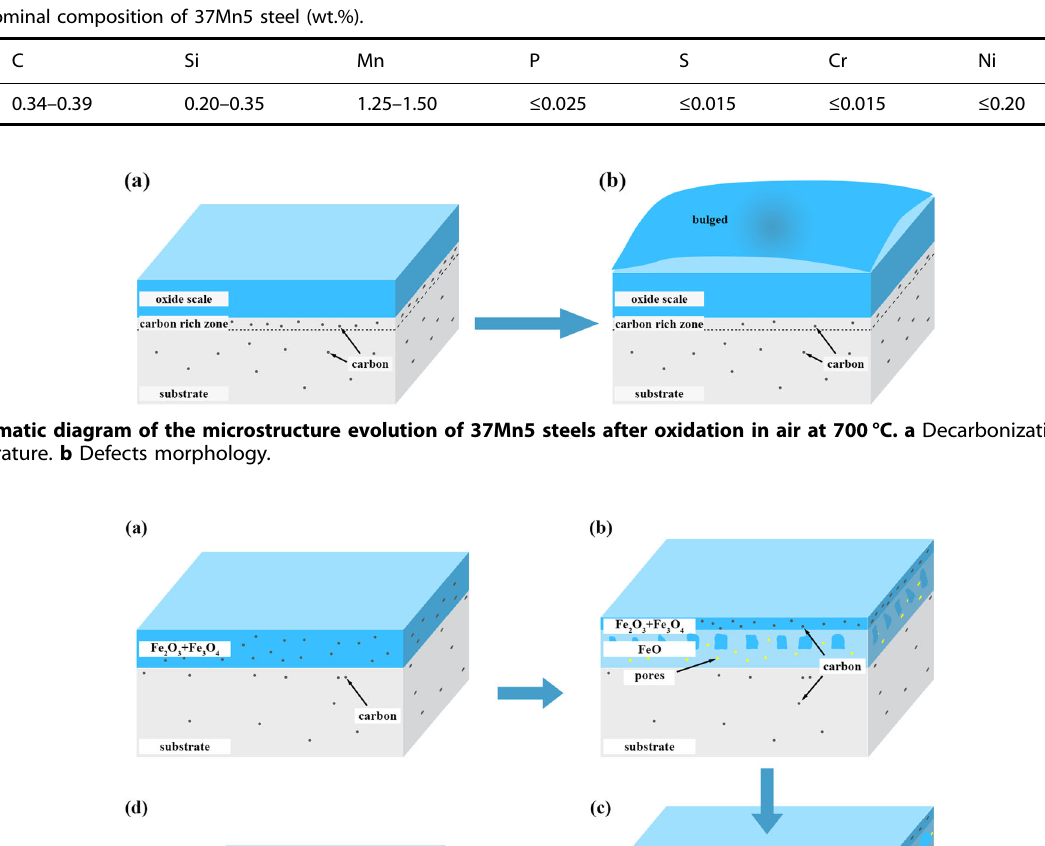
fast initial oxidation stage after 4 min. The weight gain of 37Mn5 steel in kerosene atmosphere is about four times, two times larger than that in air at 600 and 700 °C, respectively. (2) Carbon exhibits different effects in the two oxidation environments. In air, the structure of oxide scale is affected by decarburization reaction in the matrix, forming defective bulge expansion and spalling failure; in kerosene combustion environment, the decarburization reaction in the matrix is inhibited by the external C. But a loose oxide scale and pores are observed on the surface by reduction reaction between C/CO x( x = 1, 2) and iron oxides. (3) The water vapor generate after kerosene combustion can